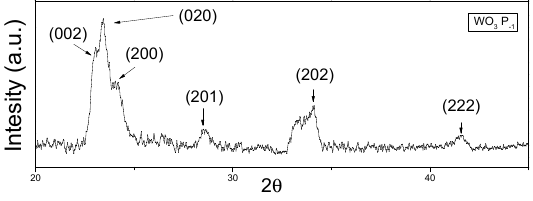
Figure 3. XRD spectra for WO 3